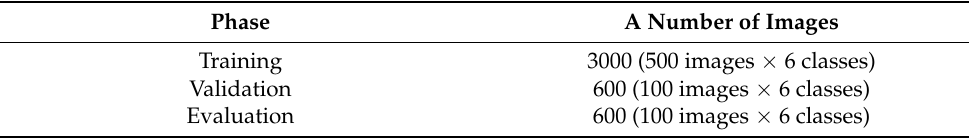
Figure 2. Sample images of TEMIS Ground-Based All-Sky Imager (ASI) dataset. Table 1. The number of images in each